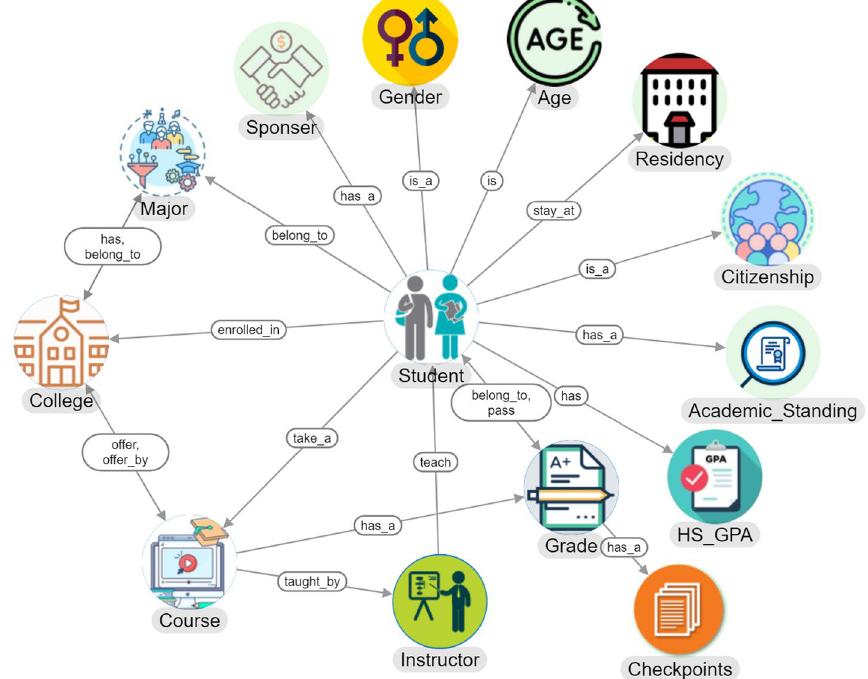
Fig. 4 Knowledge graph with entities and